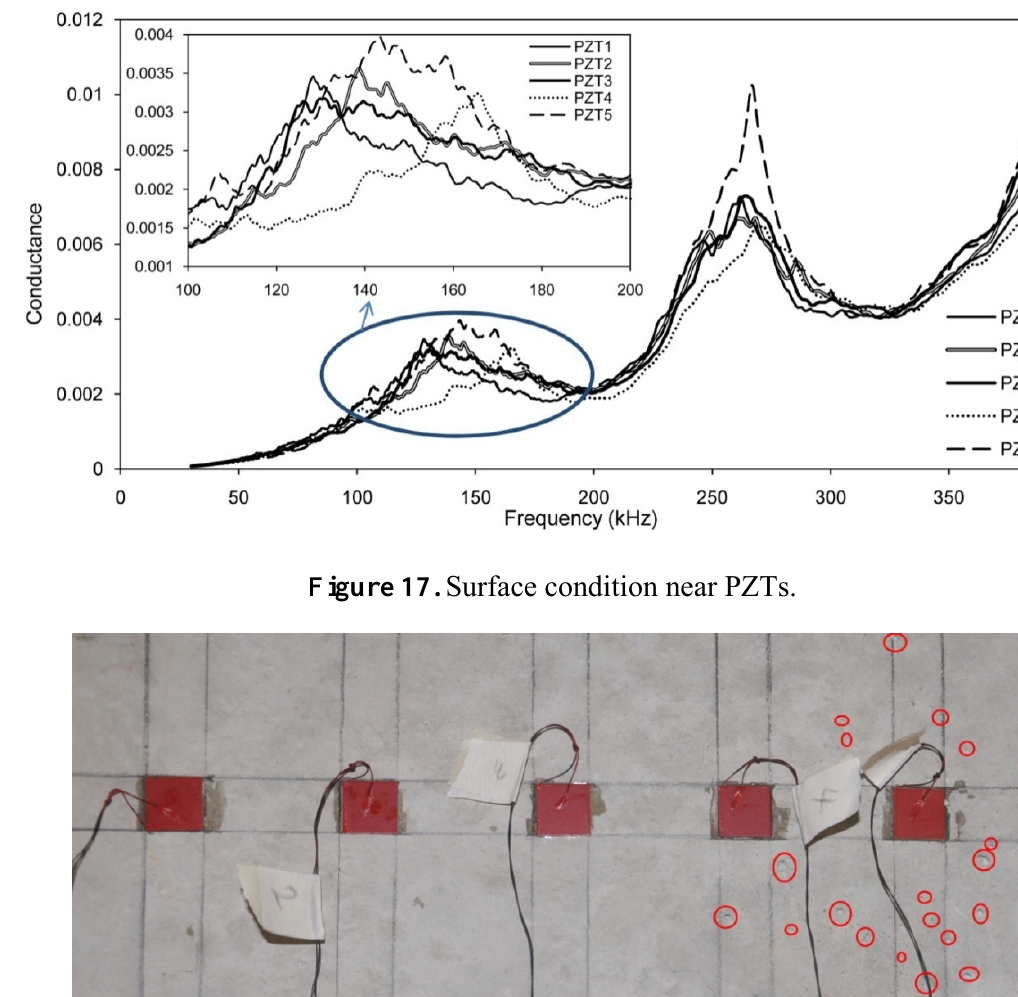
Figure 16. PZT signatures in healthy condition.